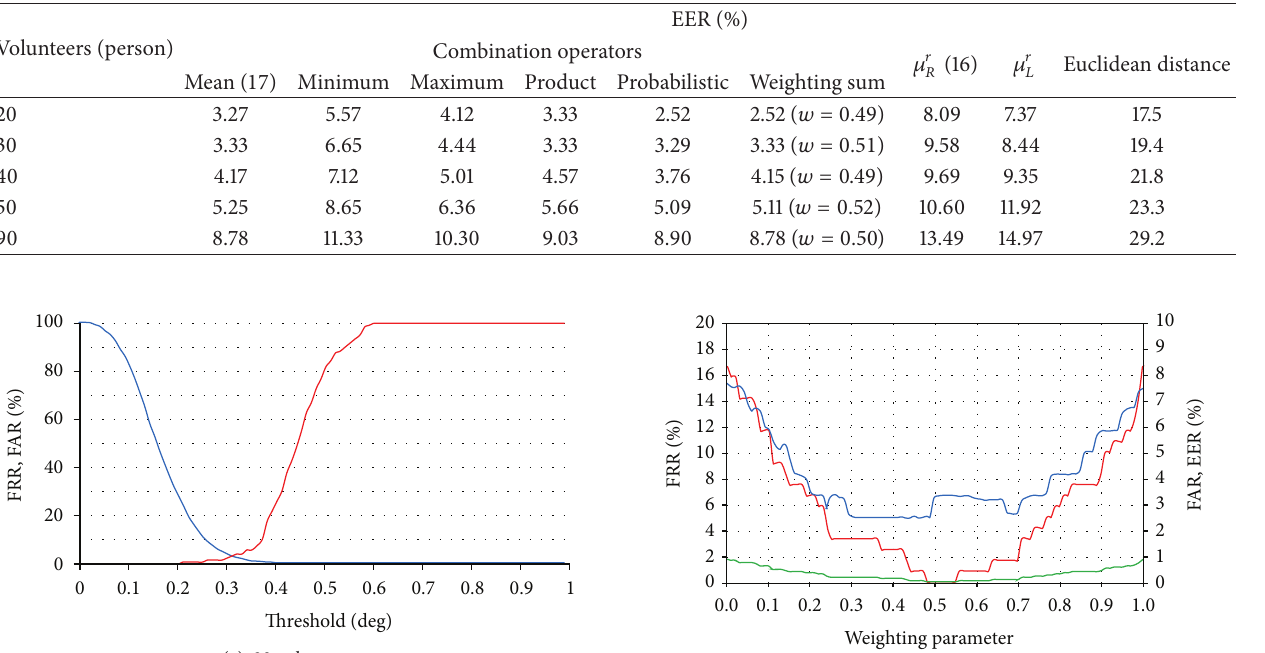
Table 6: EERs in verification of combination operators.